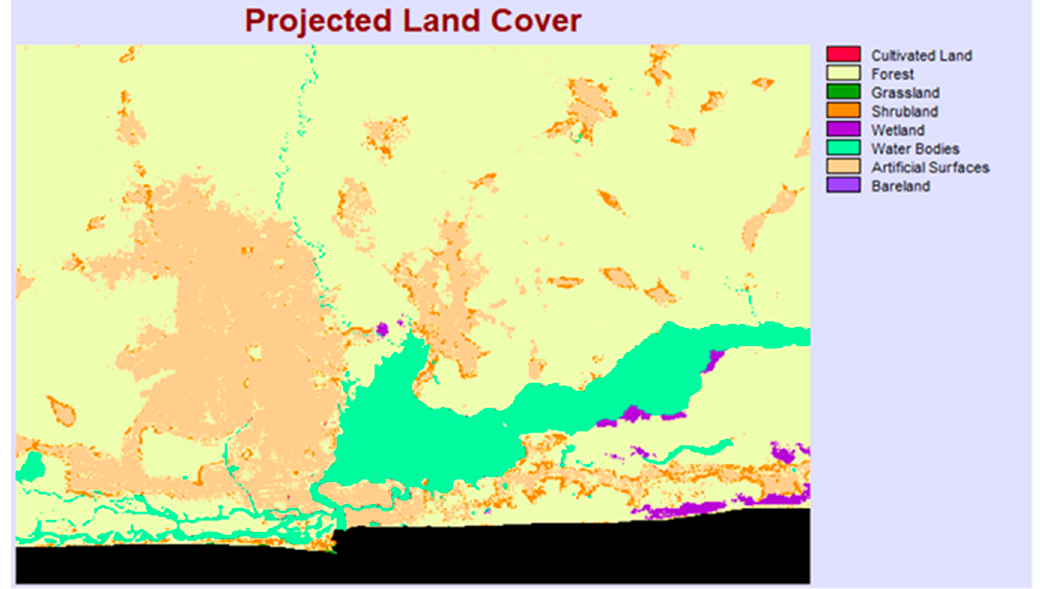
Figure 10. Predicted LULC map for year